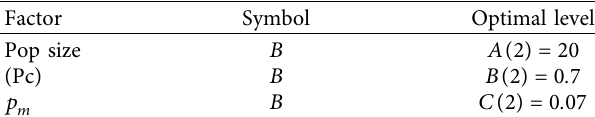
Table 3: Optimum levels of GA parameters in small size instances.